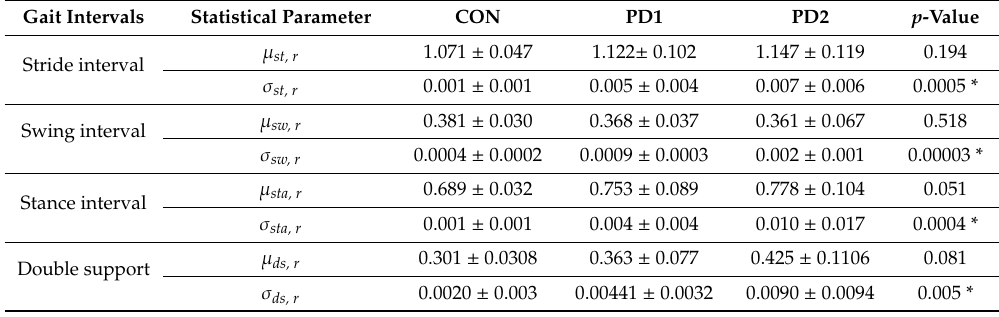
Table 3. Comparison between the mean ( ± SD) and variance ( ± SD) of gait parameters for CON, PD1, and PD2 groups, and the p -values for statistical significance.